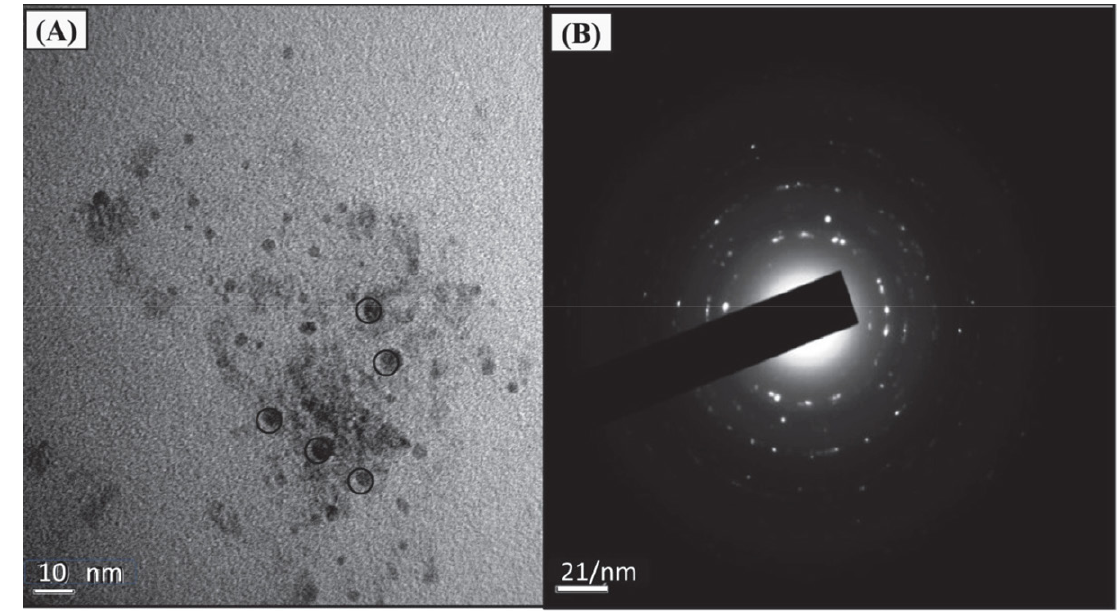
Figure 4: (A) HR-TEM and (B) SAED images of